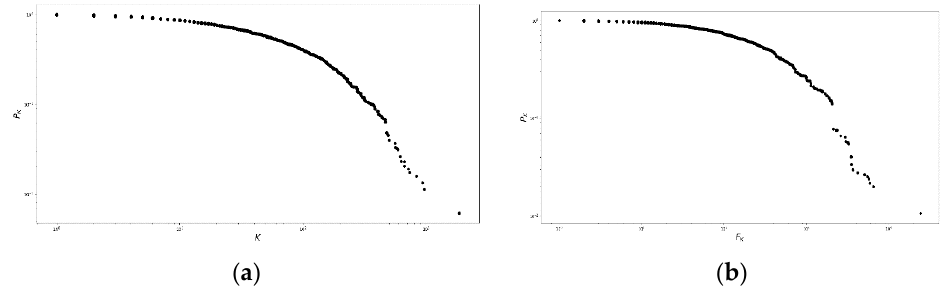
Figure 3. Nodal degree and nodal strength for the population residing in the Risaralda province. Complementary cumulative distribution functions for ( a ) the nodal degree probability distribution and ( b ) the nodal strength of the Morbidity Network of Diagnoses for the total population resident in the Risaralda province, from 2011 to 2016. Source: authors’ own calculations.